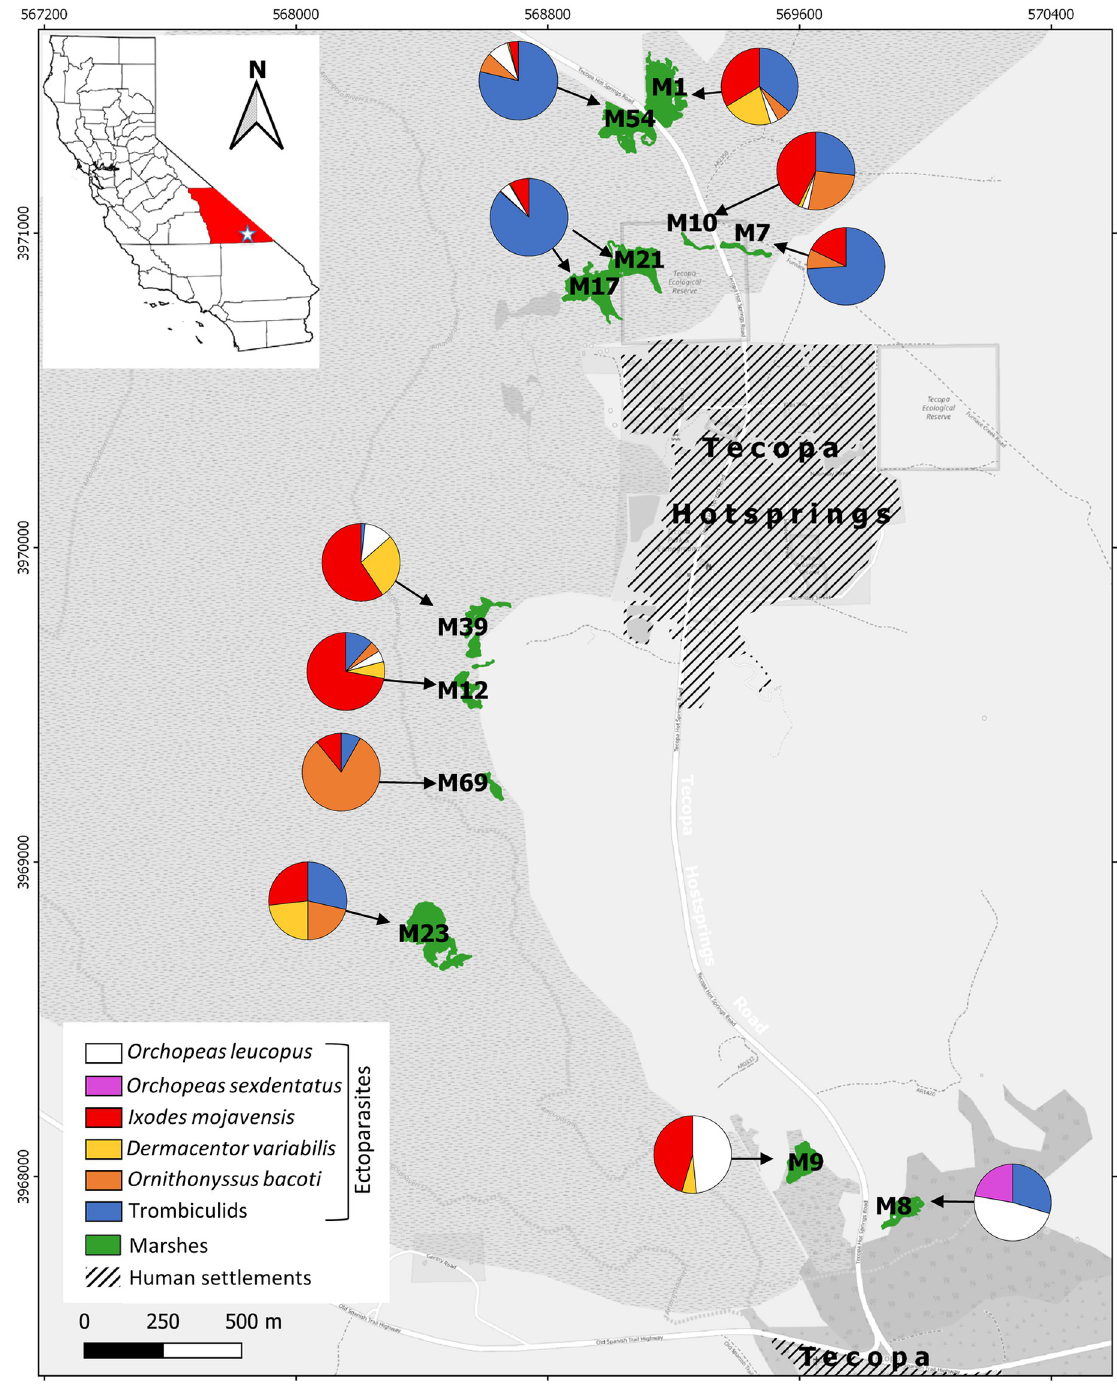
Fig 1. Map of Tecopa, California in the Mojave Desert showing pie charts of community composition of ectoparasites on rodents for eleven marsh habitat patches surveyed. Marshes are numbered according to conventions of the ad hoc Amargosa vole team. Reprinted from the OpenStreetMap vector basemap hosted by Environmental Systems Research Institute (Esri) and provided under a CC BY 4.0 license, (Map data © OpenStreetMap contributors, Map layer by Esri 2019).